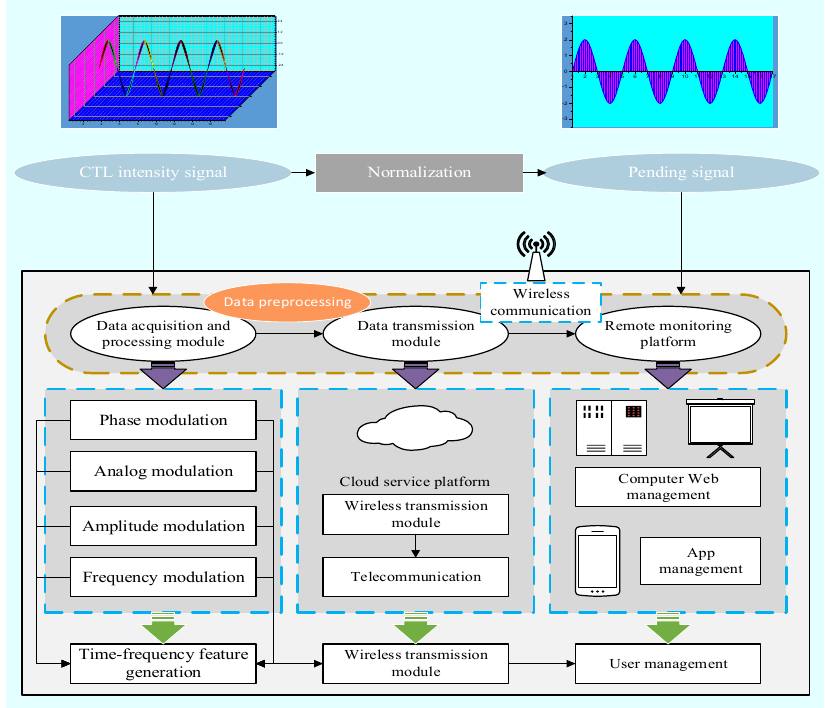
Figure 2. General schematic diagram of the wireless CTL harmful gas online detection system.